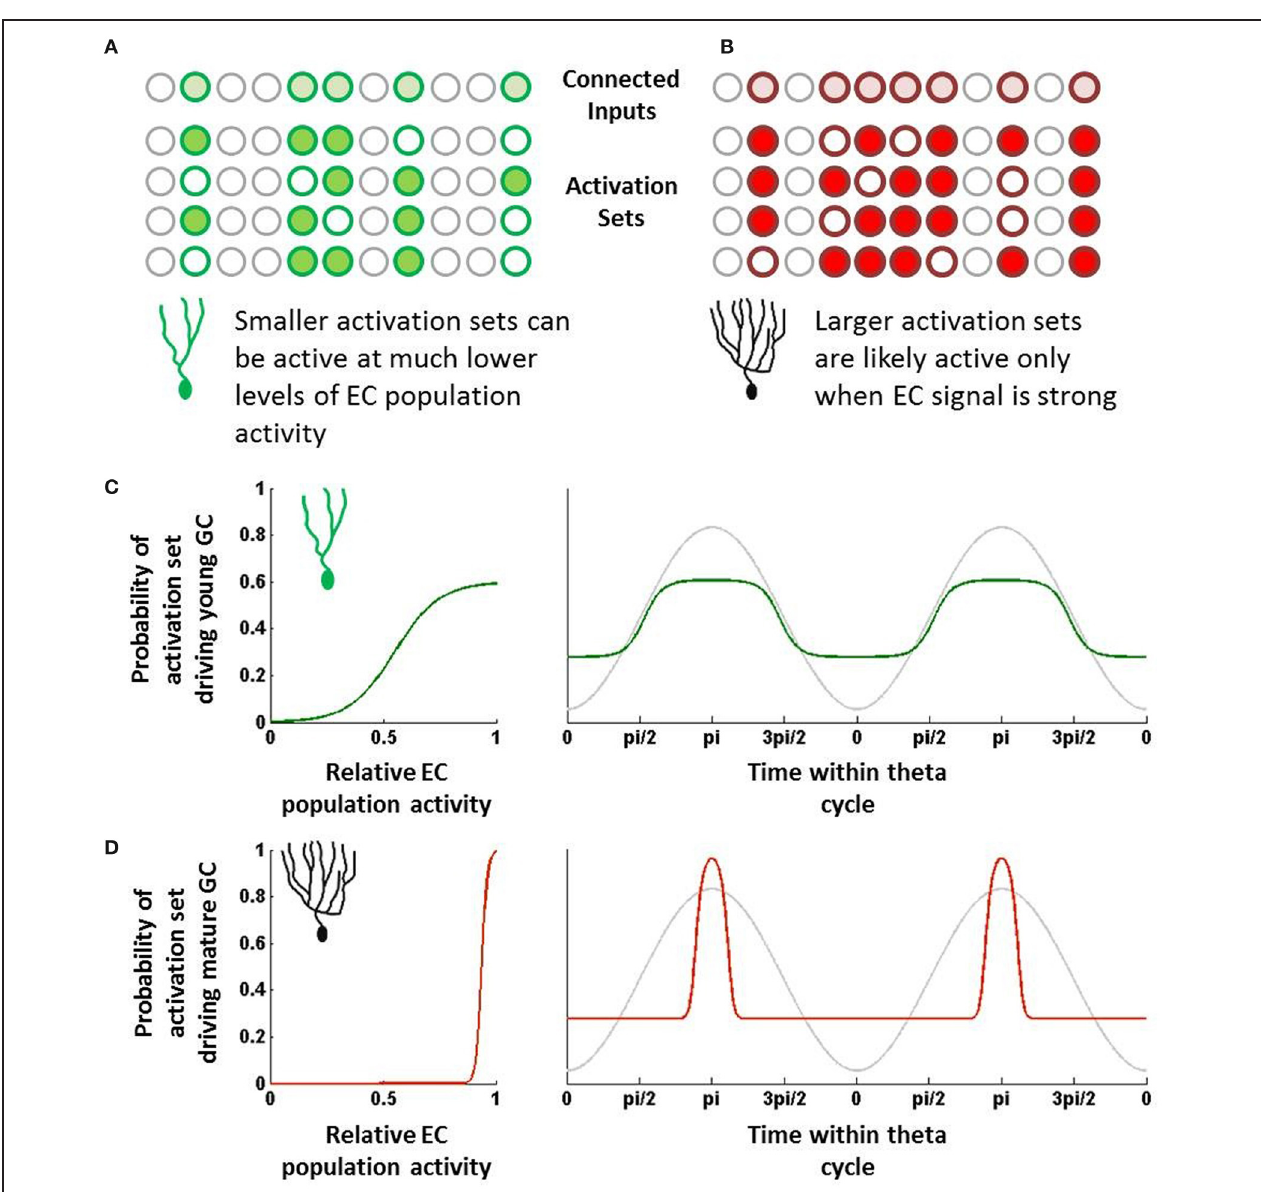
active even at times when EC population activity is fairly low (left). As a result, if EC population activity is rising and falling with theta, young neurons would be capable of being activated at many different phases (green; right). (D) Due to their large size, mature neuron activation sets will likely only be active when EC activity is strongest and when that activity maps to what the mature cell codes for (left). This will result in only a relatively narrow band of theta that is sufficient to drive the mature neuron (red;